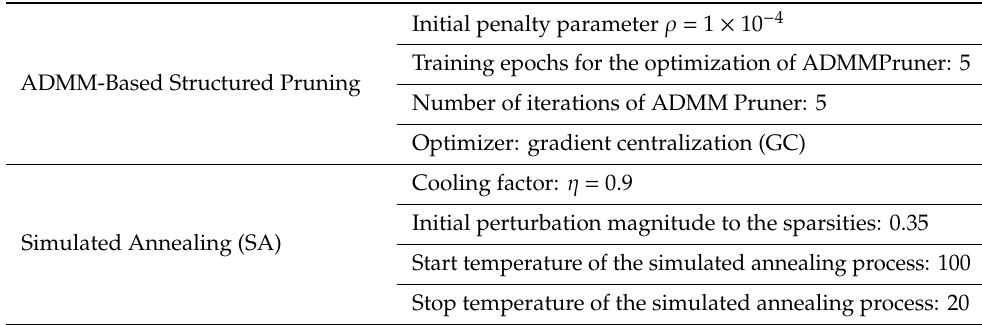
Table 5. Configurations for auto compress pruner.